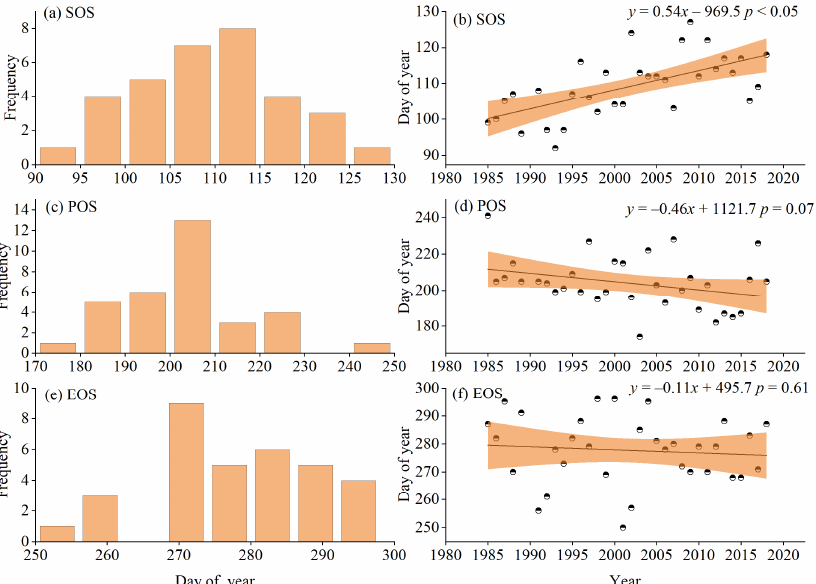
Figure 1. The dynamic trends of the phenology for S. krylovii from 1985–2018. ( a , b ) represent the distribution frequency and changing trend for the start of the growing season (SOS). ( c , d ) represent the distribution frequency and changing trend for the peak of the growing season (POS). ( e , f ) represent the distribution frequency and changing trend for the end of the growing season (EOS).